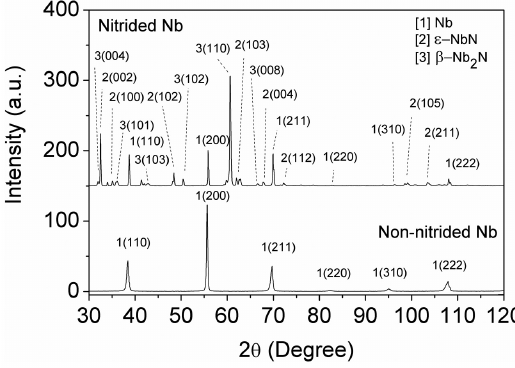
Figure 5. The XRD pattern of the nitrided and non-nitrided niobium surface.